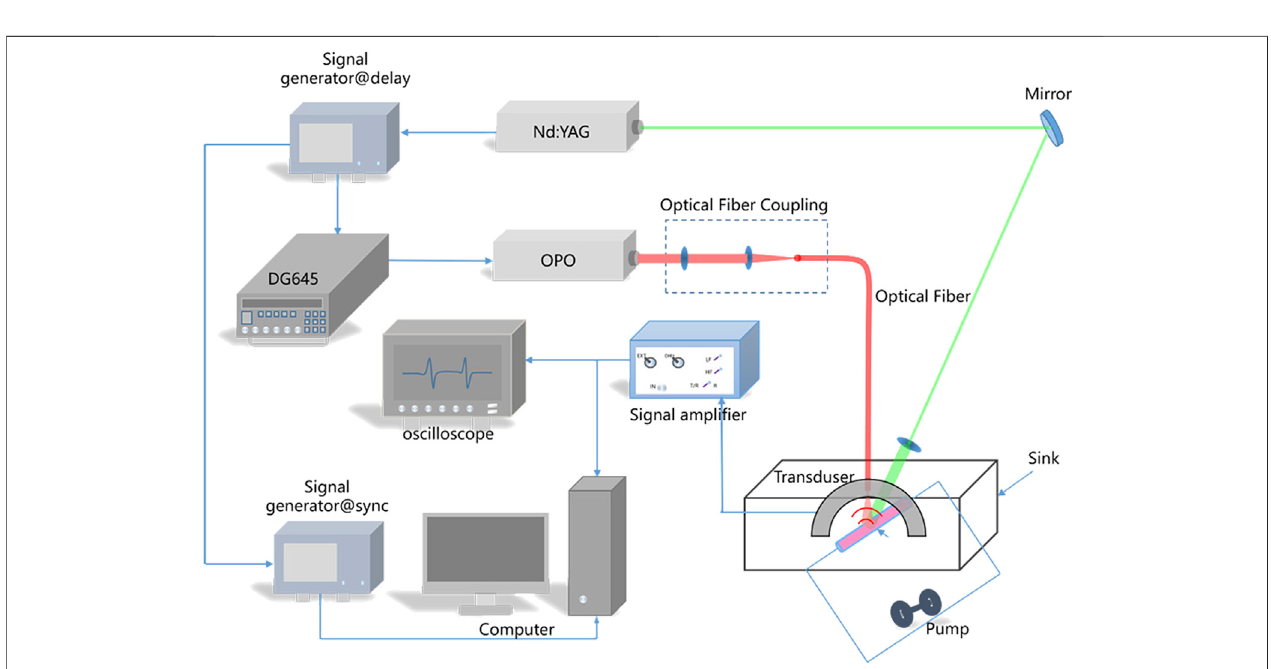
FIGURE 4 | Schematic diagram of a transient triplet differential photoacoustic imaging